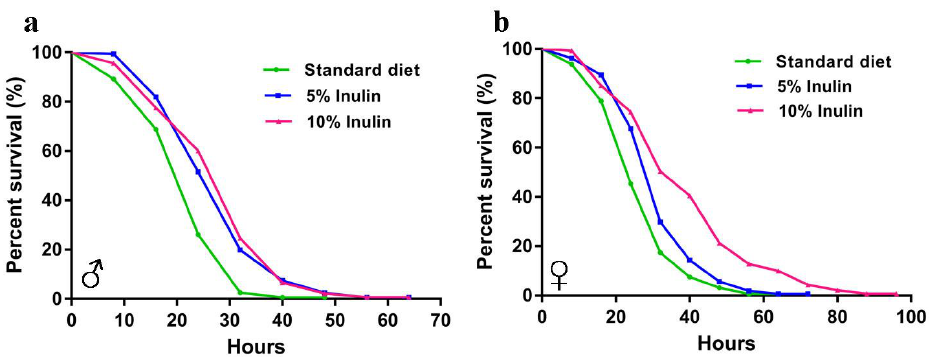
Figure 2. Starvation survival curves of InR p5545 /TM3 D. melanogaster fed an inulin-supplemented diet or a standard diet for male ( a ) and female ( b ) flies. Table 2. Statistics for starvation–survival curves. Cohort sizes, mean and median lifespans, percentage